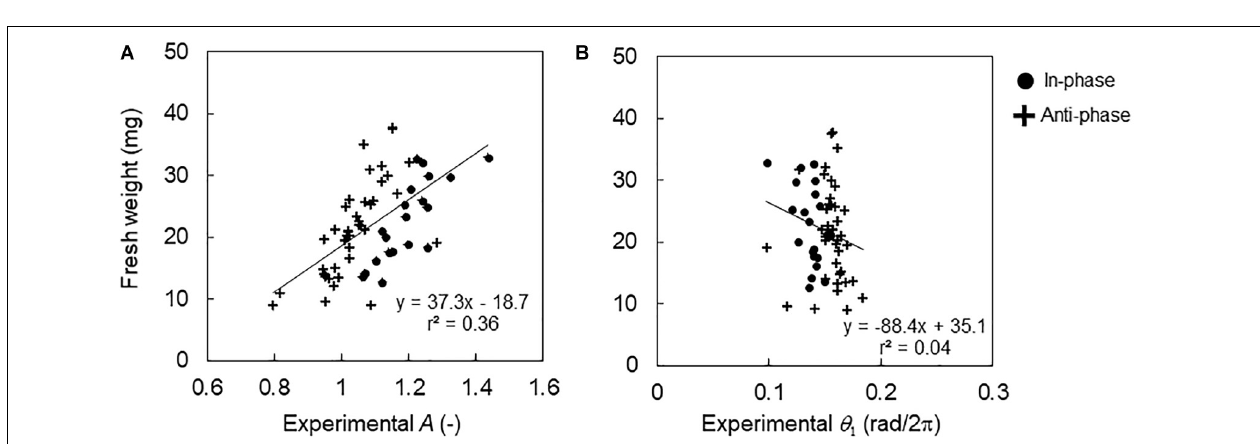
FIGURE 5 | Relationship between fresh weight and CCA1 rhythms in the control conditions. (A) Relationship between fresh weight and amplitude A in individuals. (B) Relationship between fresh weight and locking phase θ 1 in the individuals. The black lines indicate regression lines.